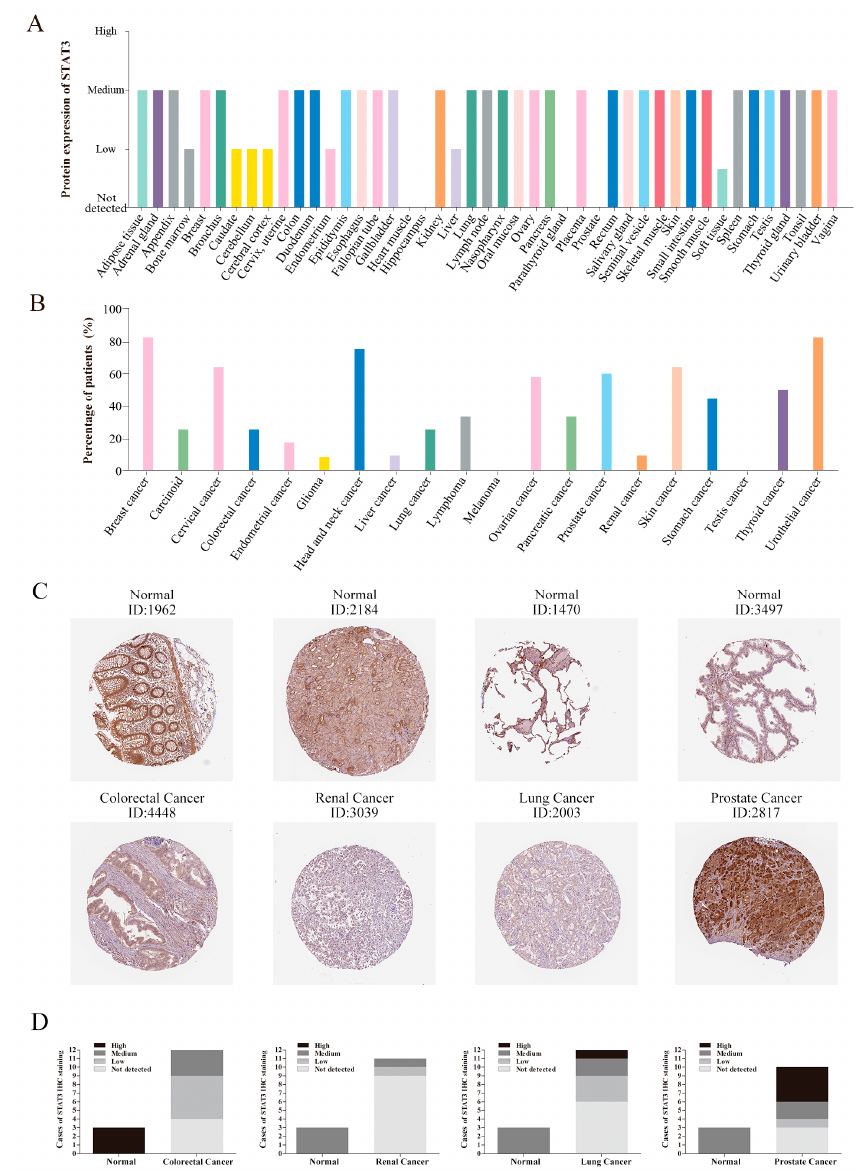
Figure 2. The protein expression of STAT3 in normal and cancer tissues. ( A ) The protein expression of STAT3 in human normal tissues. ( B ) The percentage of patients with high and medium STAT3 protein expression levels in di ff erent cancer types. The blank bar represents low or not detected protein expression. ( C ) Immunohistochemistry images of STAT3 in colorectal cancer, renal cancer, lung cancer, prostate cancer, and normal tissues detected in the HPA database. ( D ) Statistical analysis of STAT3 immunohistochemical staining data in normal tissues ( n = 3) and colorectal cancer ( n = 12, p = 0.007), renal cancer ( n = 11, p = 0.006), lung cancer ( n = 12, p = NS), prostate cancer ( n = 10, p = NS)